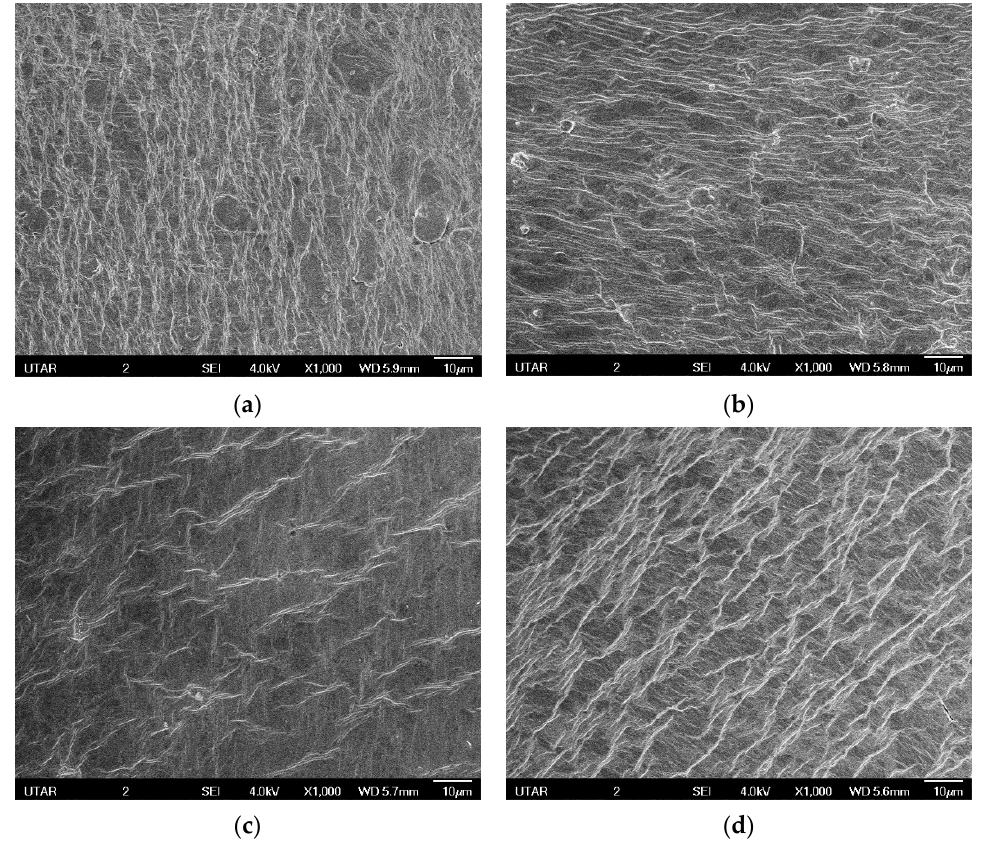
Figure 1. SEM observations of the NBR-GO membrane surfaces. ( a ) 0.5 pphr GO. ( b ) 1.0 pphr GO. ( c ) 1.5 pphr GO. ( d ) 2.0 pphr GO.